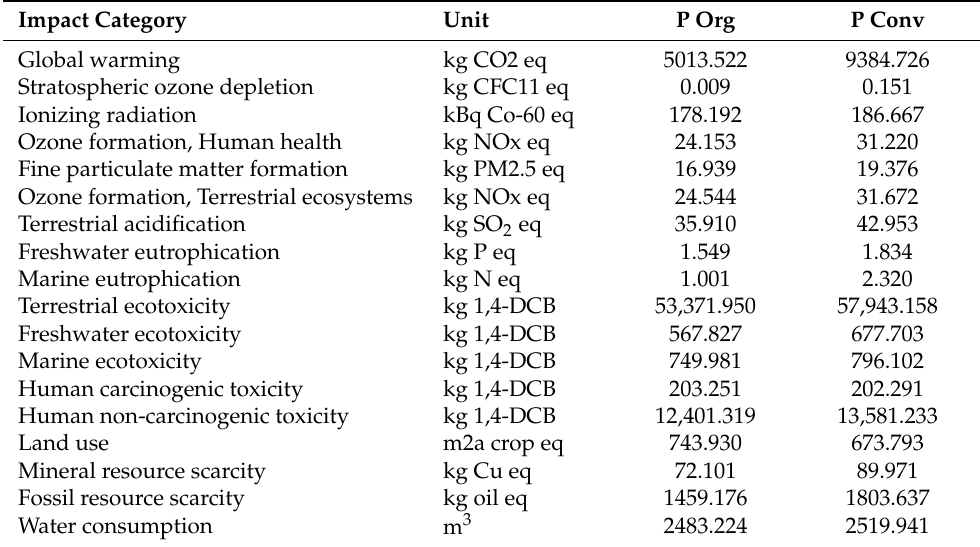
Table 4. Characterization factors and environmental impact per hectare in early organic and conven- tional potato cultivation (*).